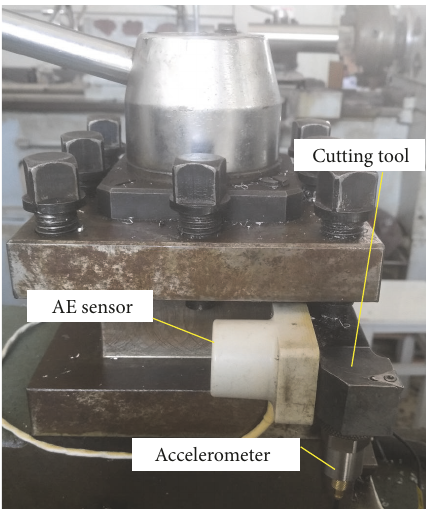
Figure 3: Sensors